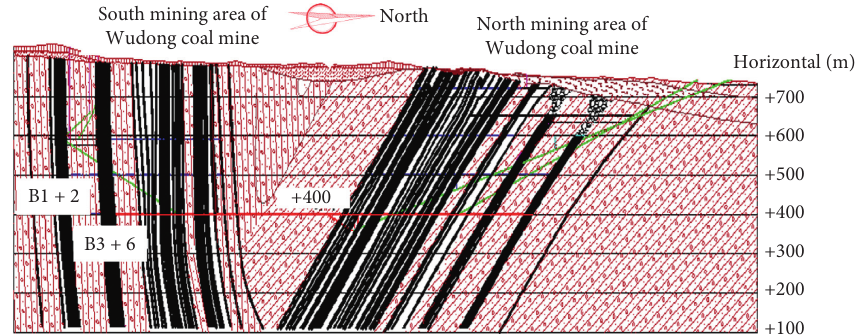
Figure 3: The overall geological section of